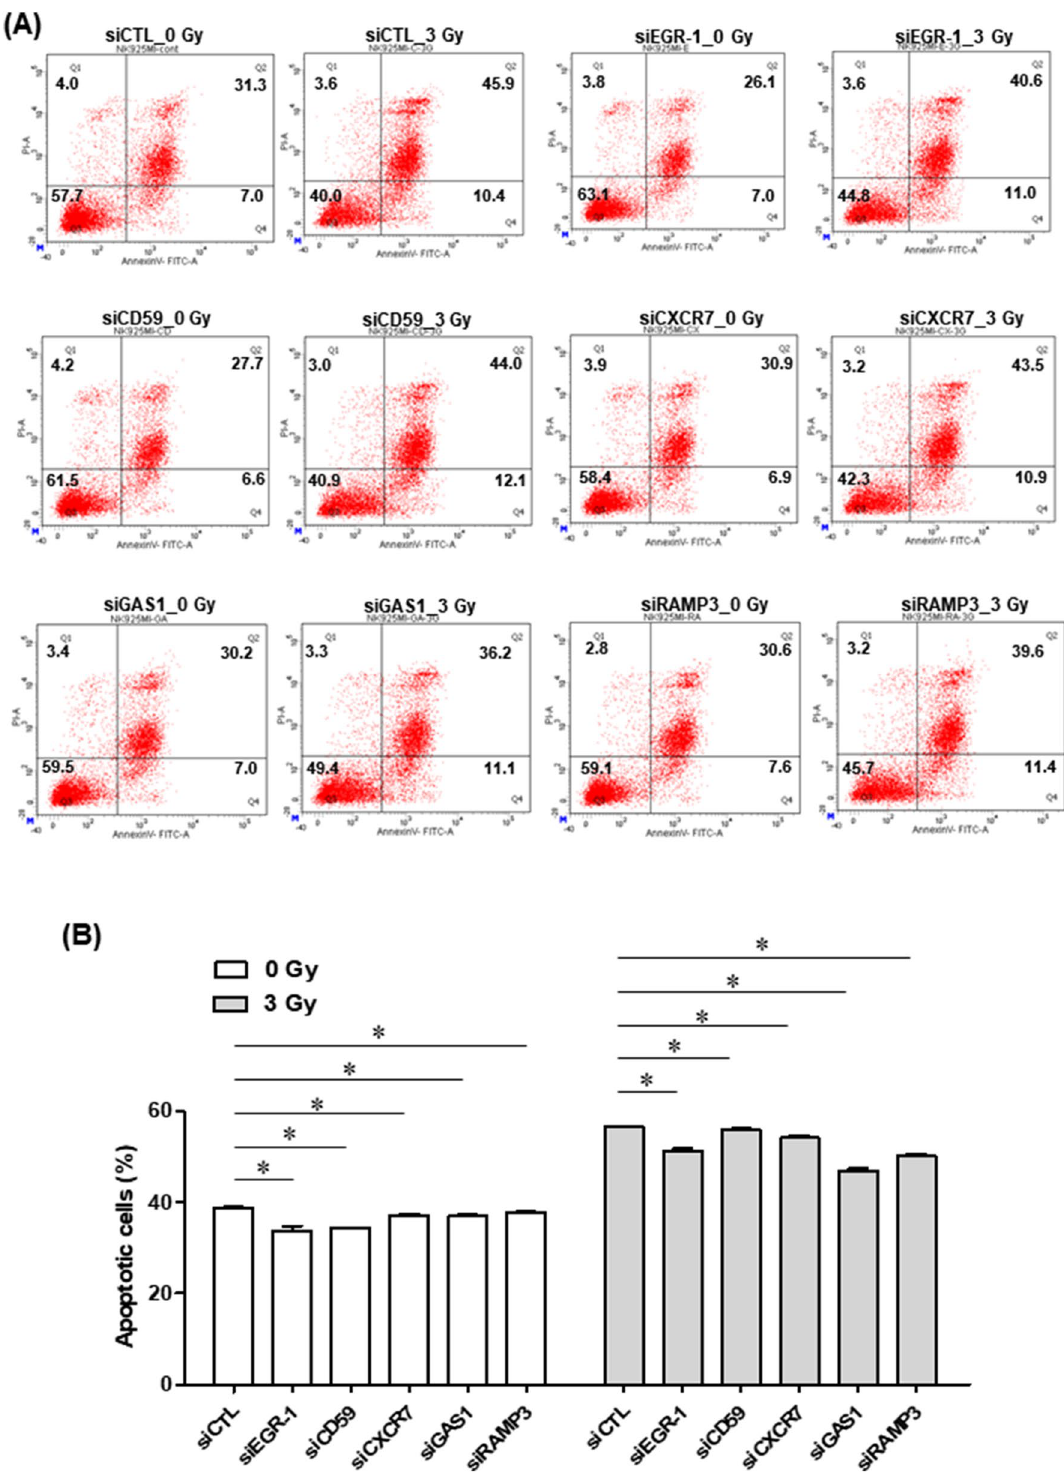
Figure 7. NK92MI cells were transfected with siRNA control, siEGR-1, siCD59, siCXCR7, siGAS1, and siRAMP3; 48 h later, gamma irradiation (3 Gy) was applied for 24 h, and apoptosis was measured ( A ). Dot plots are separated into four quadrants: Q1 (Annexin V − /PI + : cell death), Q2 (Annexin V + /PI + : late apoptotic cells), Q3 (Annexin V − /PI − : living cells), and Q4 (Annexin V + /PI − : early apoptotic cells). The percentage of apoptotic cells measured using flow cytometry ( B ). Values are presented as mean ± SEM (n = 3). P values were determined using Student’s t-test. * P < 0.05 versus siCTL siRNA, small interfering